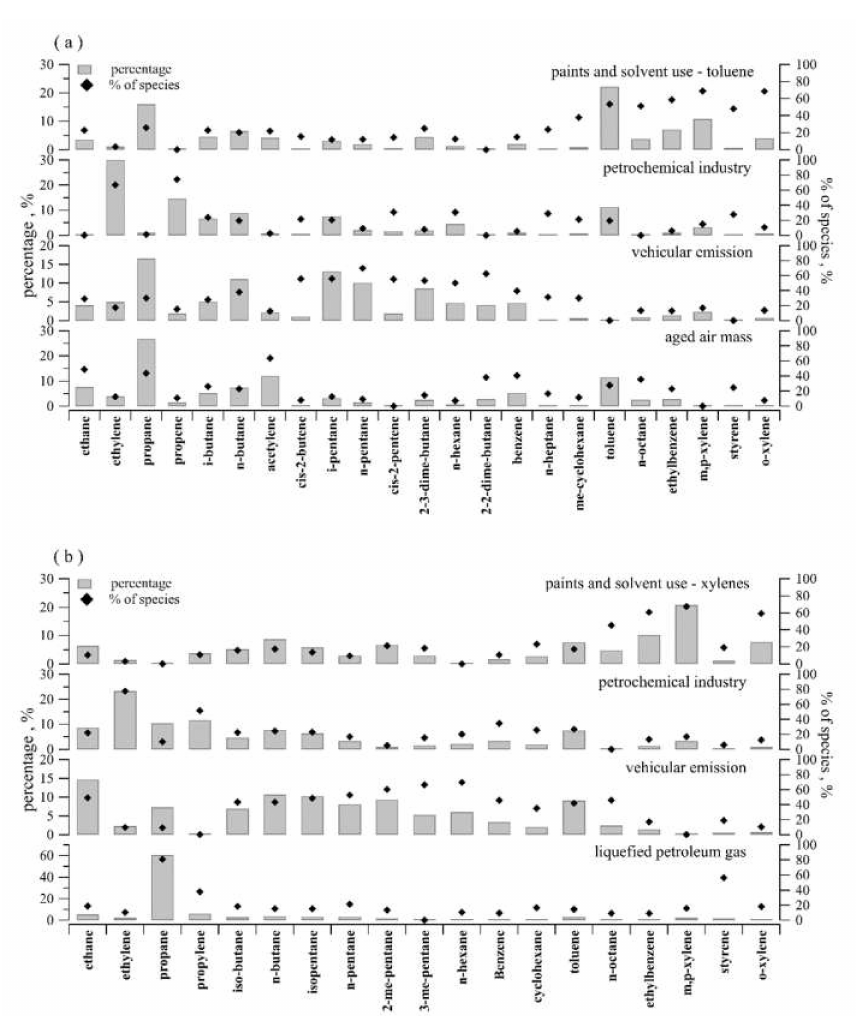
Figure 9. Chemical profiles of NMHCs for individual positive matrix factorization (PMF)-resolved factors at ( a ) the DSH site and ( b ) the PD site from 1–31 July 2017. The bar represents the percentage of individual species in the total mixing ratios for all fitting species. The black-filled diamond indicates the relative contribution of each factor in the measured mixing ratio of individual